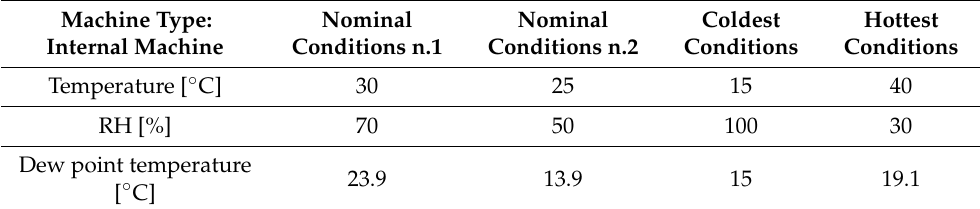
Table A2. Dew point for internal machine normalised